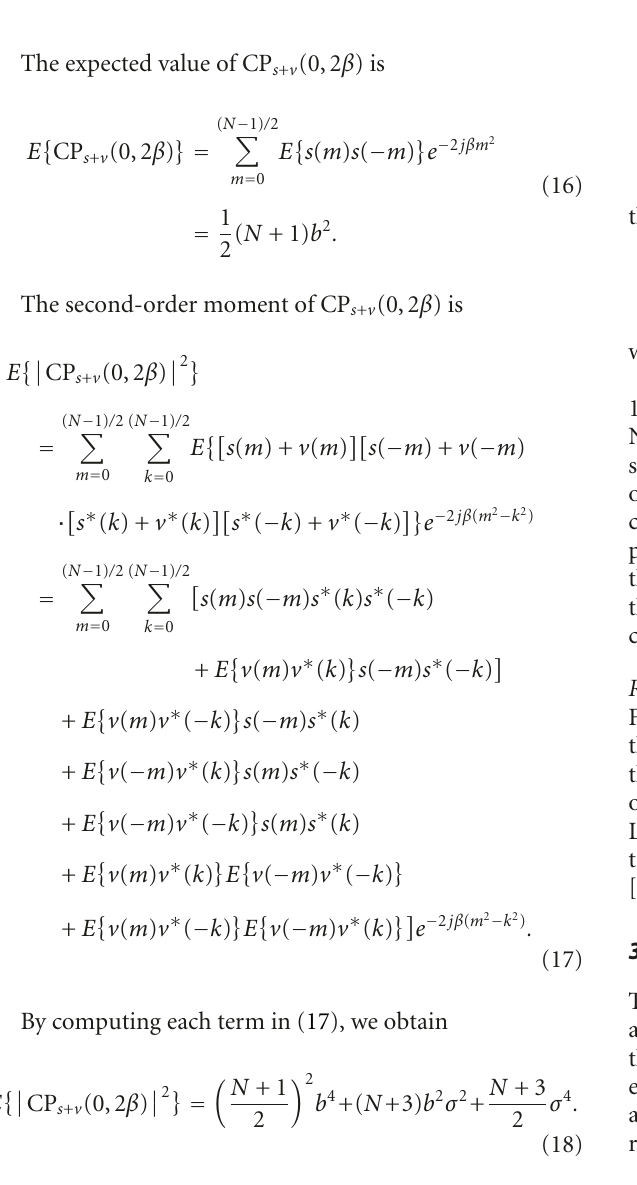
Figure 2: The signal separation based on CLEAN